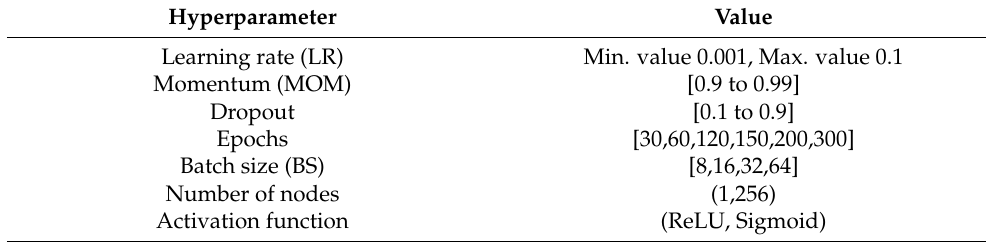
Table 2. Hyperparameters of